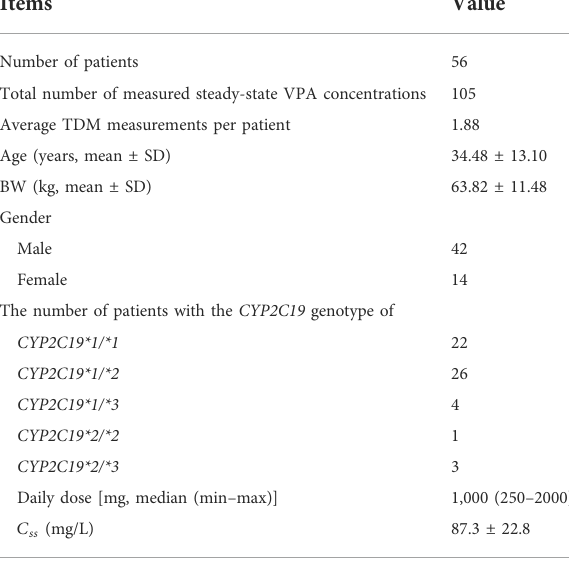
TABLE 4 Descriptions of our external dataset.